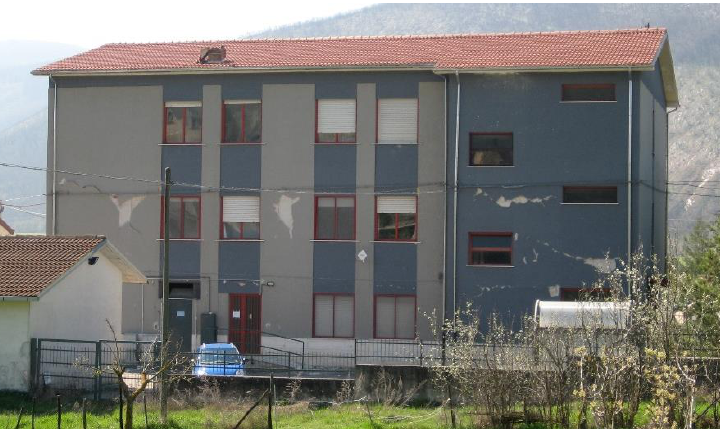
Figure 18. Picture of the monitored structure (Municipality of Navelli): damage of the infill panels. More details in [3].